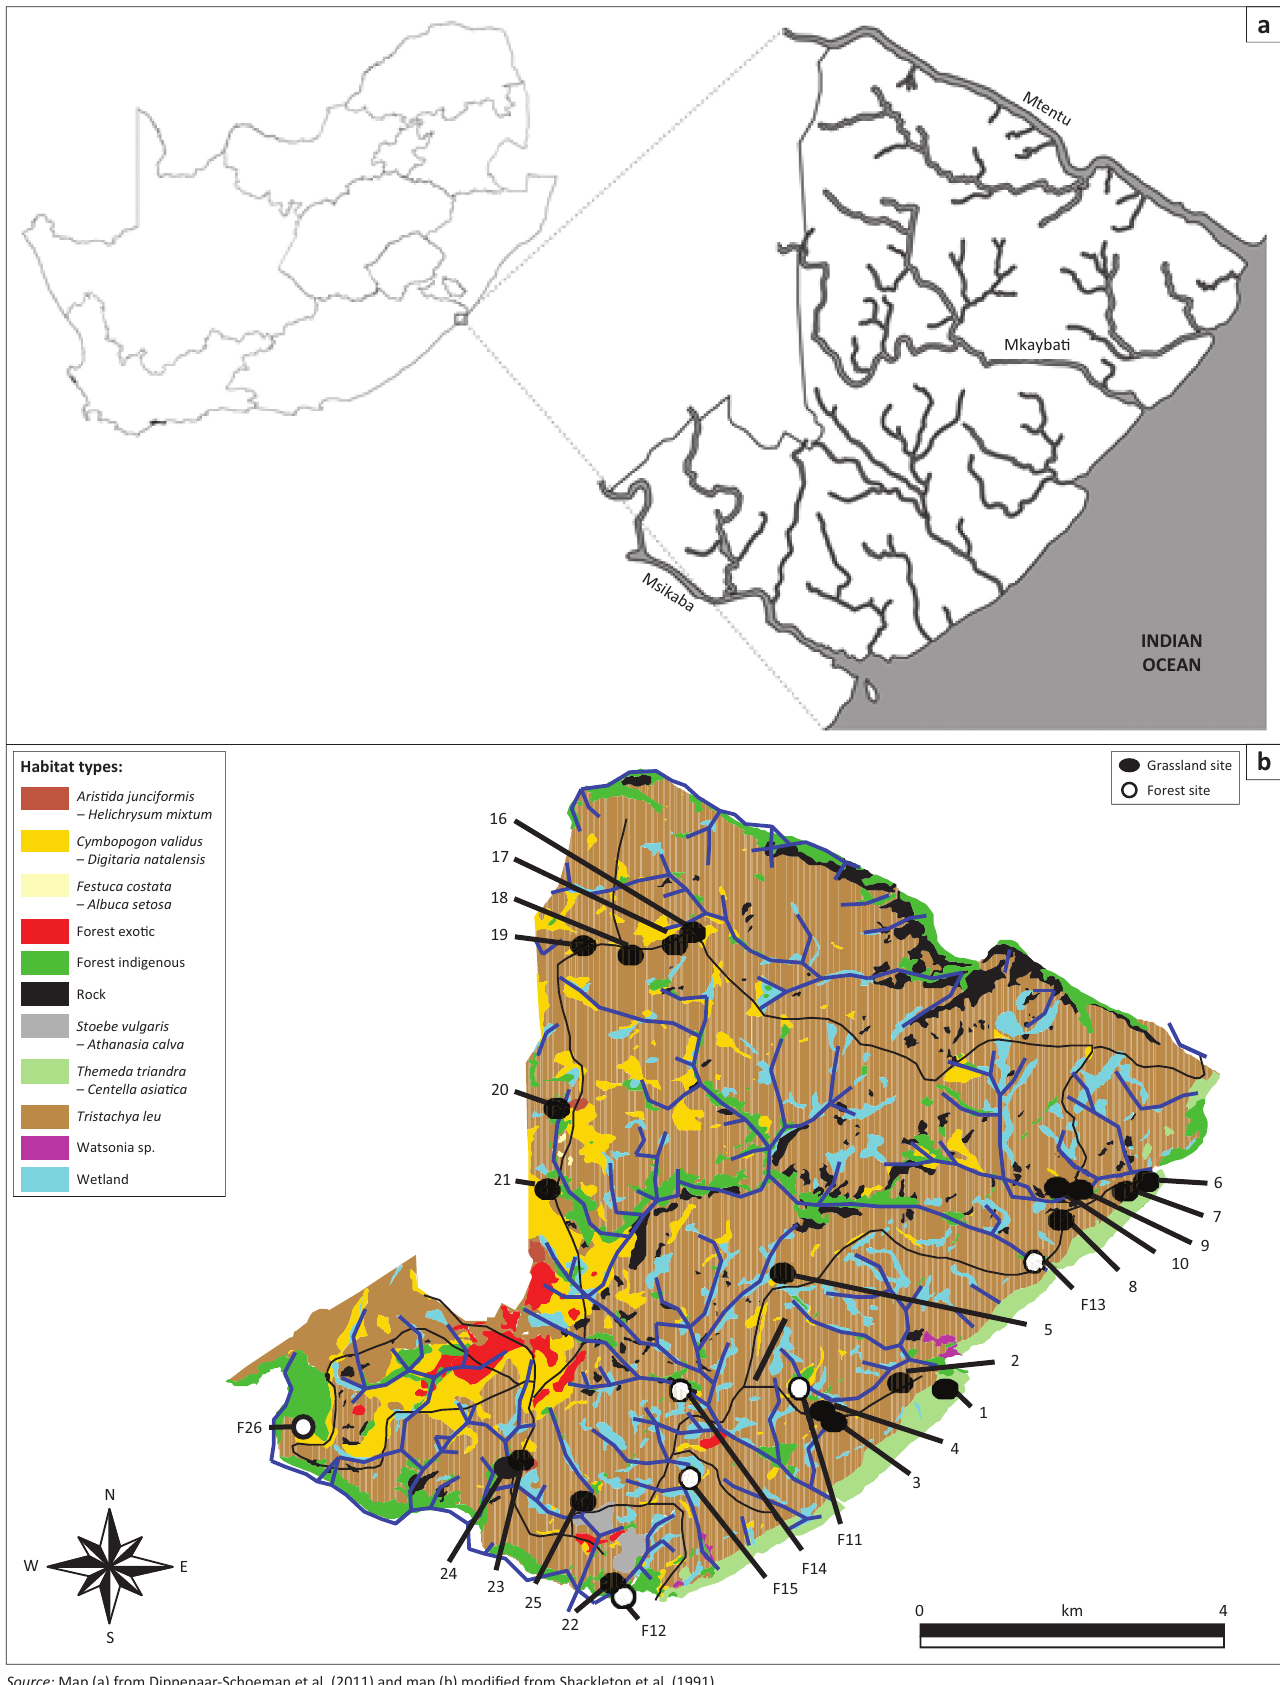
FIGURE 1: (a) South Africa showing position of Mkambati Nature Reserve and map of Mkambati NR showing rivers and boundaries and (b) map showing vegetation types and location of the forest and grassland sampling